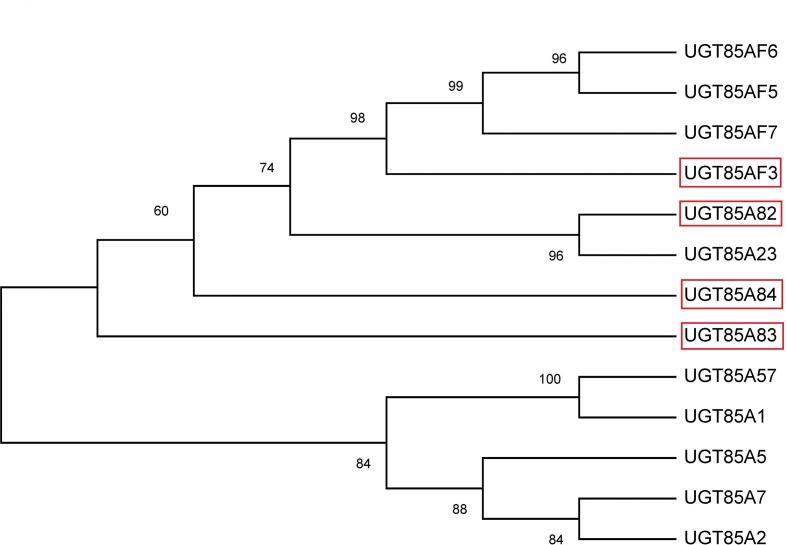
Phylogenetic analysis of the four candidate terpenoid OfUGTs with other plant terpenoid UGTs. The phylogenetic tree was constructed according to the Maximum Likelihood method by MEGA 6.1 software.